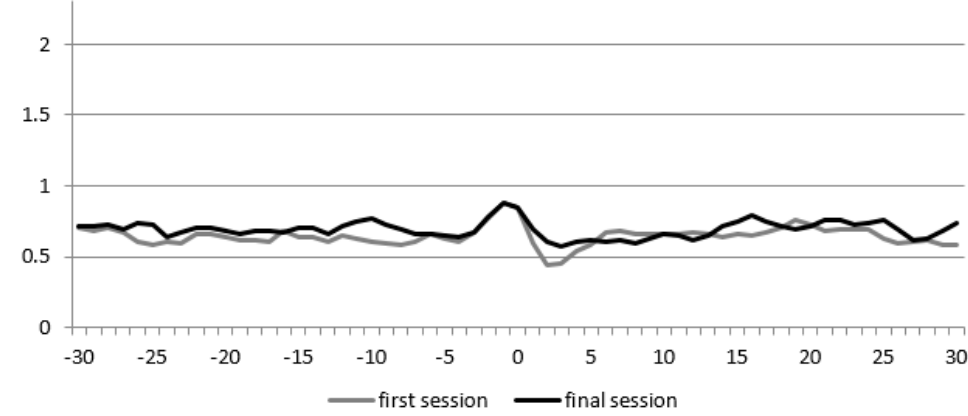
Figure 4. Diagonal Cross-Recurrence Profile (DCRP) of participant 3. The X-axis displays the delay in steps of 0.5 s, and the Y-axis the recurrence rate (the proportion of accurate turn-taking).